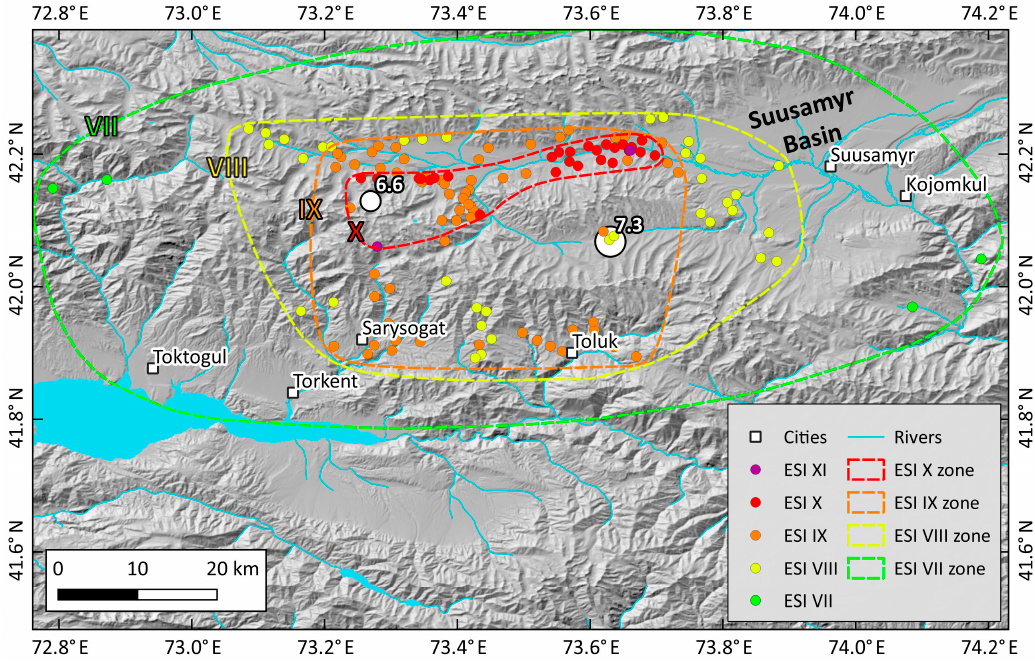
Figure 5. Map of ESI2007 intensities compiled in this study. The location of the main shock and the strongest well-located aftershock are shown. See the Supplementary Data for details on each data point.